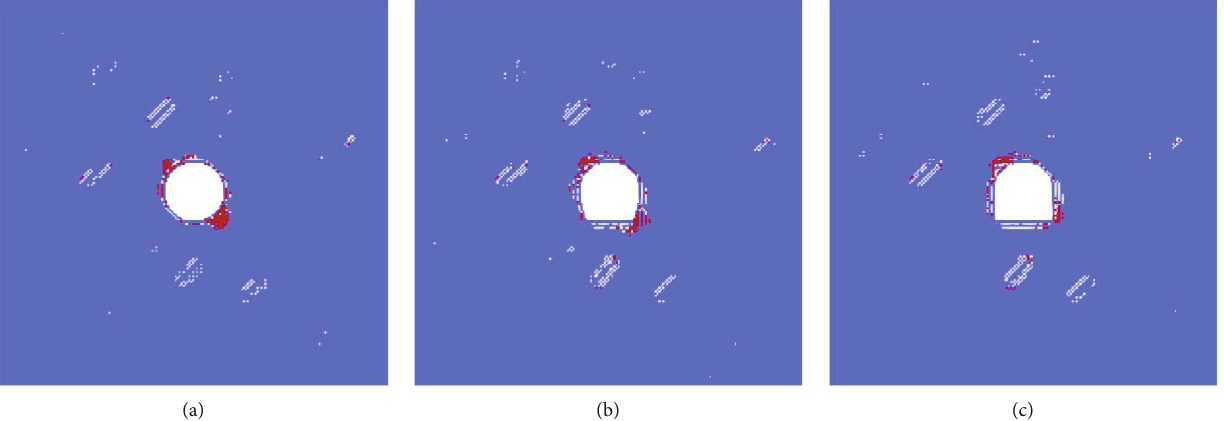
Figure 5: Excavation damage range under di ff erent tunnel shapes. (a) Circular-shaped hole. (b) Horseshoe-shaped hole. (c) “ U ” -shaped